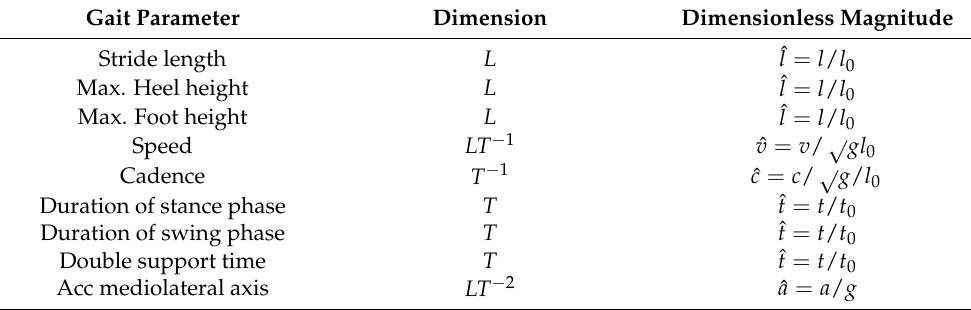
Table 4. Dimensionless normalization of gait parameters [31], where l 0 is the subject’s height, t 0 is the stride length and g is gravity (9.81 m/s 2